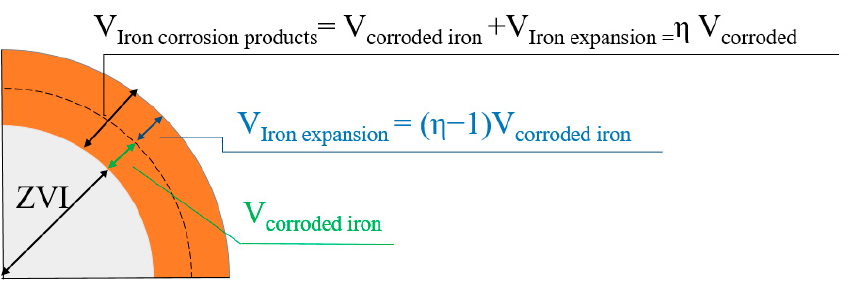
Figure 6. A representation of a ZVI particle, showing corroded iron volume, iron expansion volume and iron corrosion products. and iron corrosion